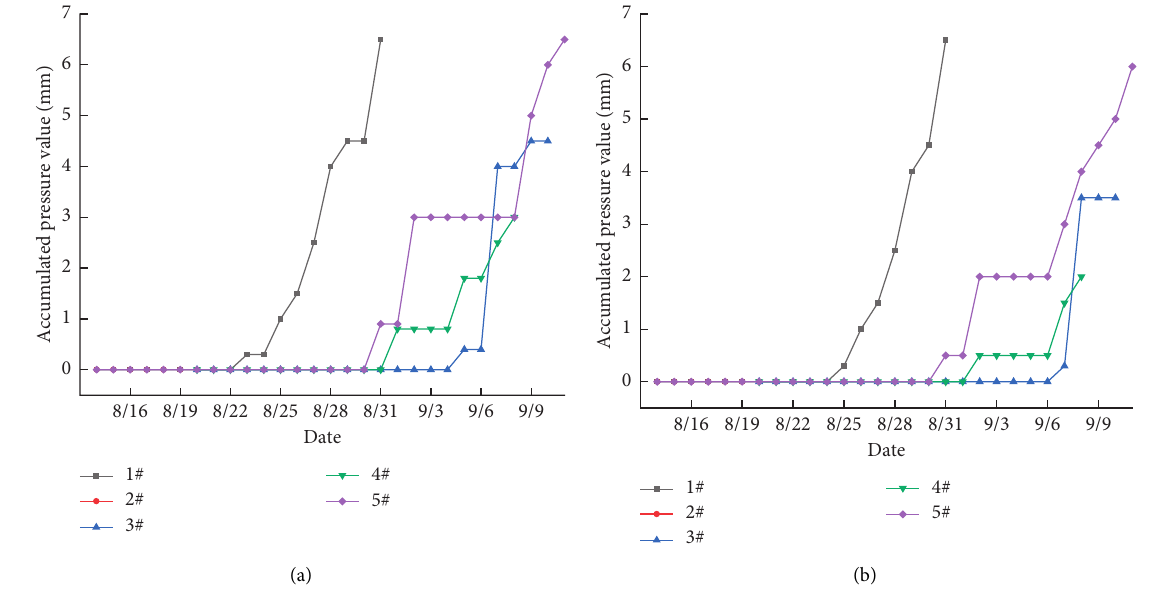
Figure 13: Monitoring data of deep base point. (a) Single hydraulic prop support. (b) Anchor cable support.